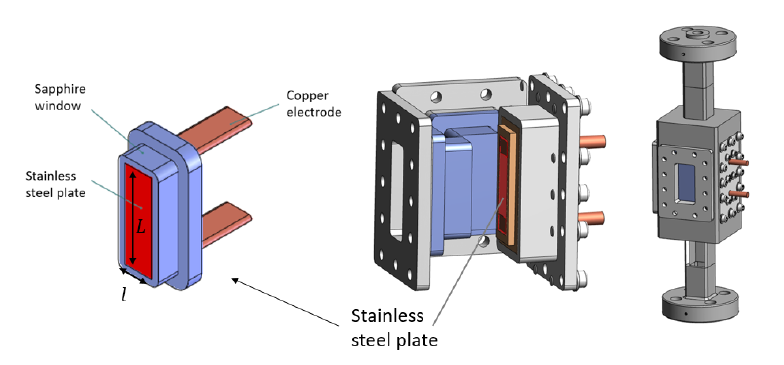
Figure 3. The 3D schematic of the future test section. The heated element is drawn in red: The heated length L ≈ 5 × 10 − 1 m, heated width l ≈ 1 × 10 − 2 m, and thickness of the metallic plate are to be determined.